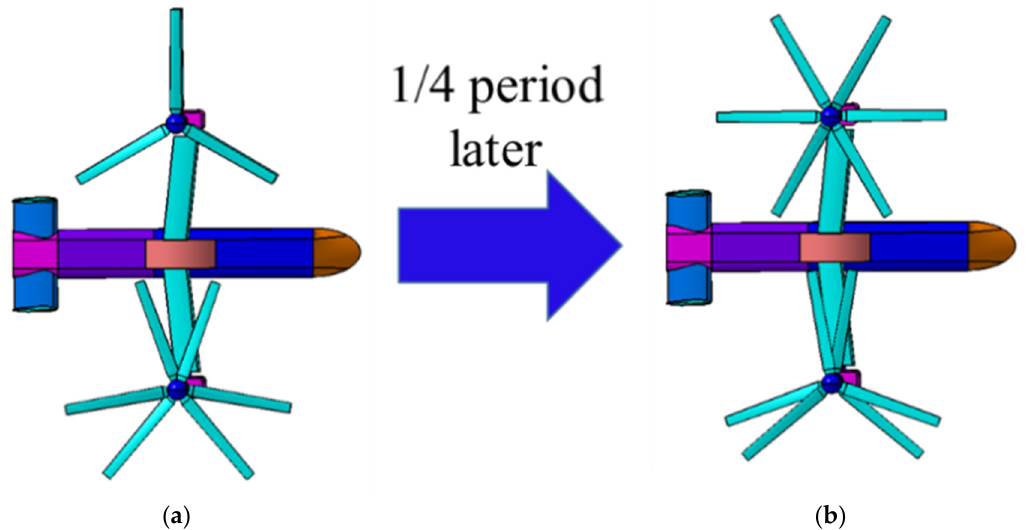
Figure 7. The relationship between situation “left scissors angle = 0°, right scissors angle = 20°” ( a ) and situation “left scissors angle = 90°, right scissors angle = 110°” ( b ).